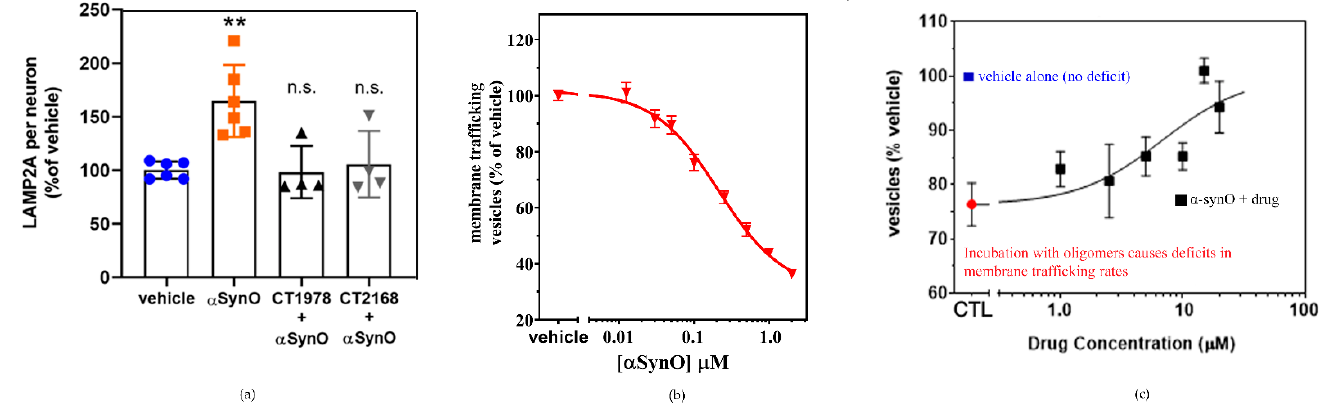
Figure 8. S2R modulators reverse the effects of α -synuclein oligomers on lysosomal-associated membrane protein 2A expression and trafficking. ( a ) Microscopy images of a cell culture exposed to α -synuclein oligomer with or without S2R modulators and stained for lysosomal-associated membrane protein 2A (LAMP2A) were quantified. (** p < 0.01, ANOVA with Dunnett’s test for multiple comparisons; n.s., not significantly different compared with vehicle-treated cells.) ( b ) Cultures treated with increasing concentrations of α -synuclein oligomer ( α -synO) exhibit membrane trafficking deficits. ( c ) These trafficking deficits are blocked by treatment with S2R modulators. Adapted from Ref. [4], 2021, Limegrover, et al.